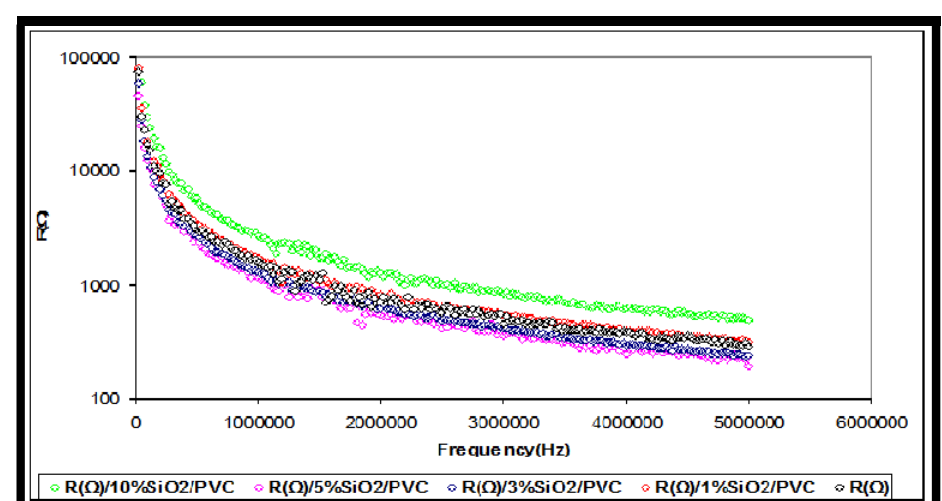
Fig. 15: Frequency dependent volume resistance of SiO